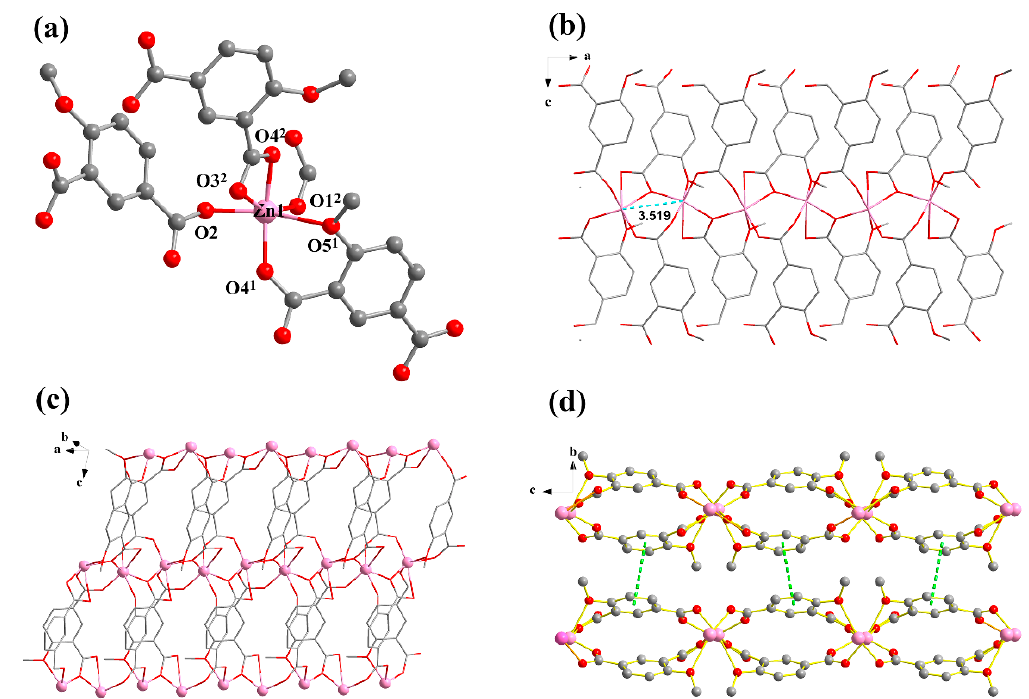
Figure 1. ( a ) Coordination environment of compound 1 , [Zn(MIPA)] n . ( b ) 1D metal chain of 1 . The a, b and c represent a axis, b axis and c axis, respectively. ( c ) The 2D layers of 1 . ( d ) The π ··· π interaction between layers. All hydrogen atoms and guest molecules are omitted for clarity. Symmetry codes: (1) x , 0.5 − y , − 0.5 + z , (2) 0.5 + x , y , 0.5 − z .